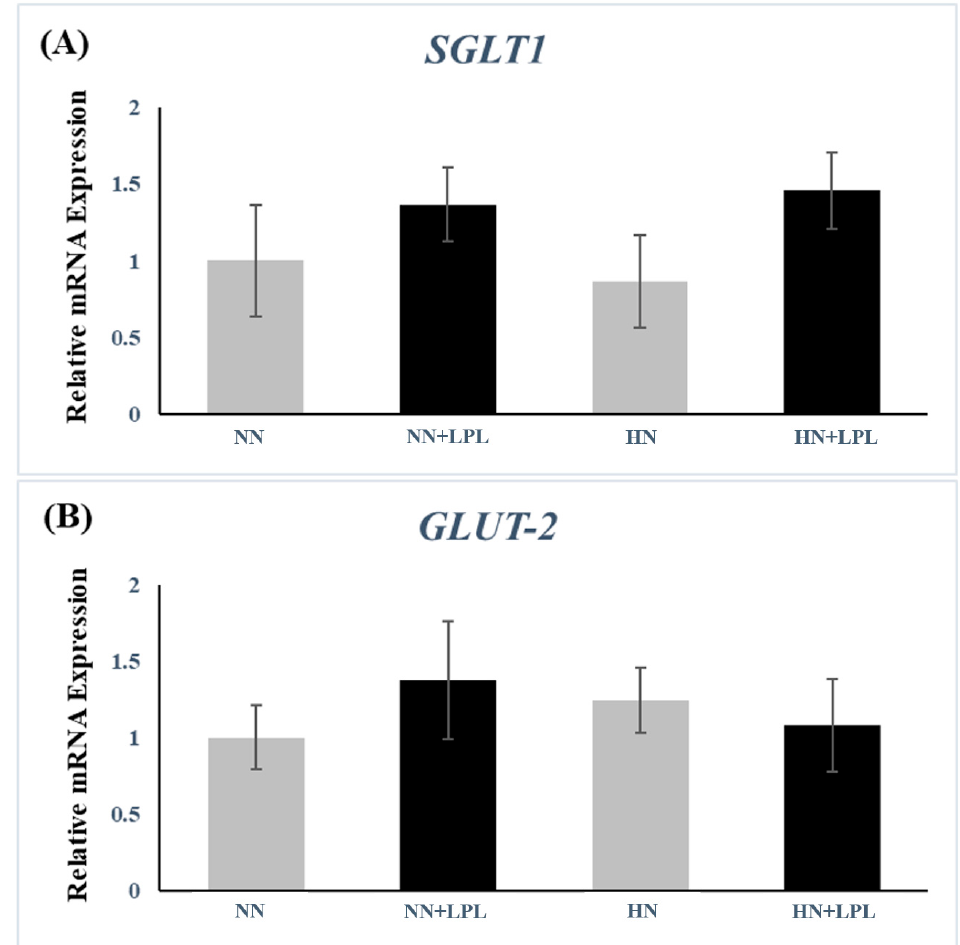
Figure 3. Quantitative gene expression of glucose transporter in small intestine following LPL supplementation. ( A ) The gene expression of SGLT1. ( B ) The gene expression of GLUT2. Error bars indicate the standard error of the mean. SGLT1, sodium-dependent glucose transporter 1; GLUT2, glucose transporter 2. Abbreviation: NN, Normal nutrition diet; NN + LPL, NN + 500 g/t of LPL; HN, NN + 0.5% CP and 50 Kcal/kg; HN + LPL, HN + 500 g/t LPL.